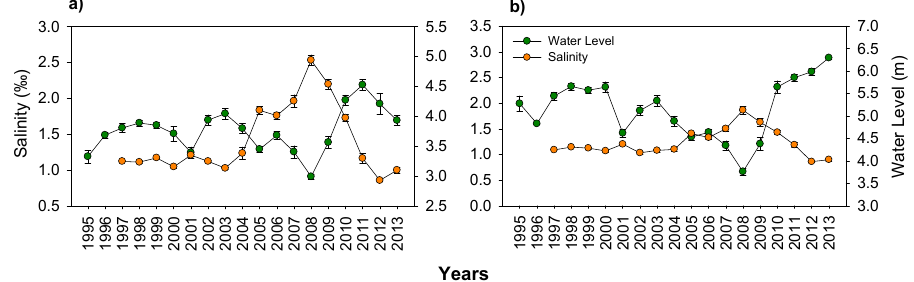
Figure 3. Changes in yearly mean (with ± SE) salinity and water level in ( a ) Lake Mogan and ( b ) Lake Eymir. Note the scale differences on the y ‐ axes.